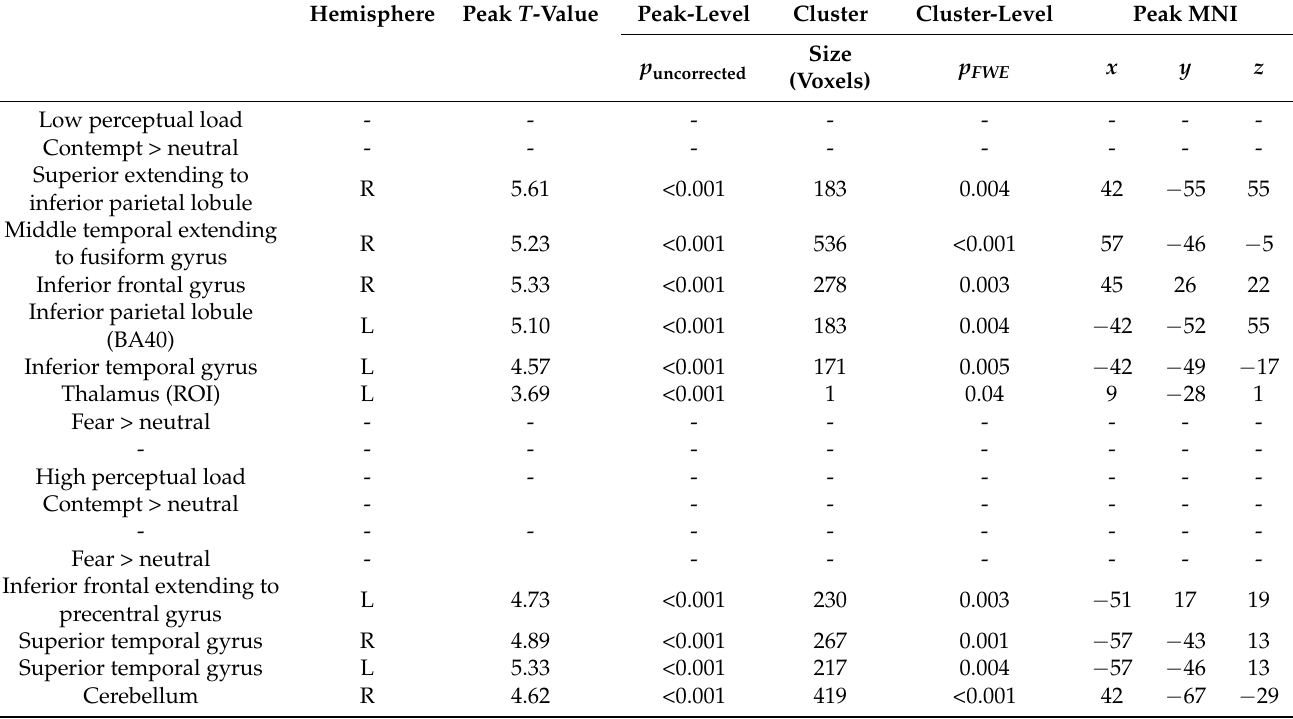
Table 2. Threat main effects: Brain regions showing increased activation in response to threatening (vs. neutral) faces under low and high perceptual